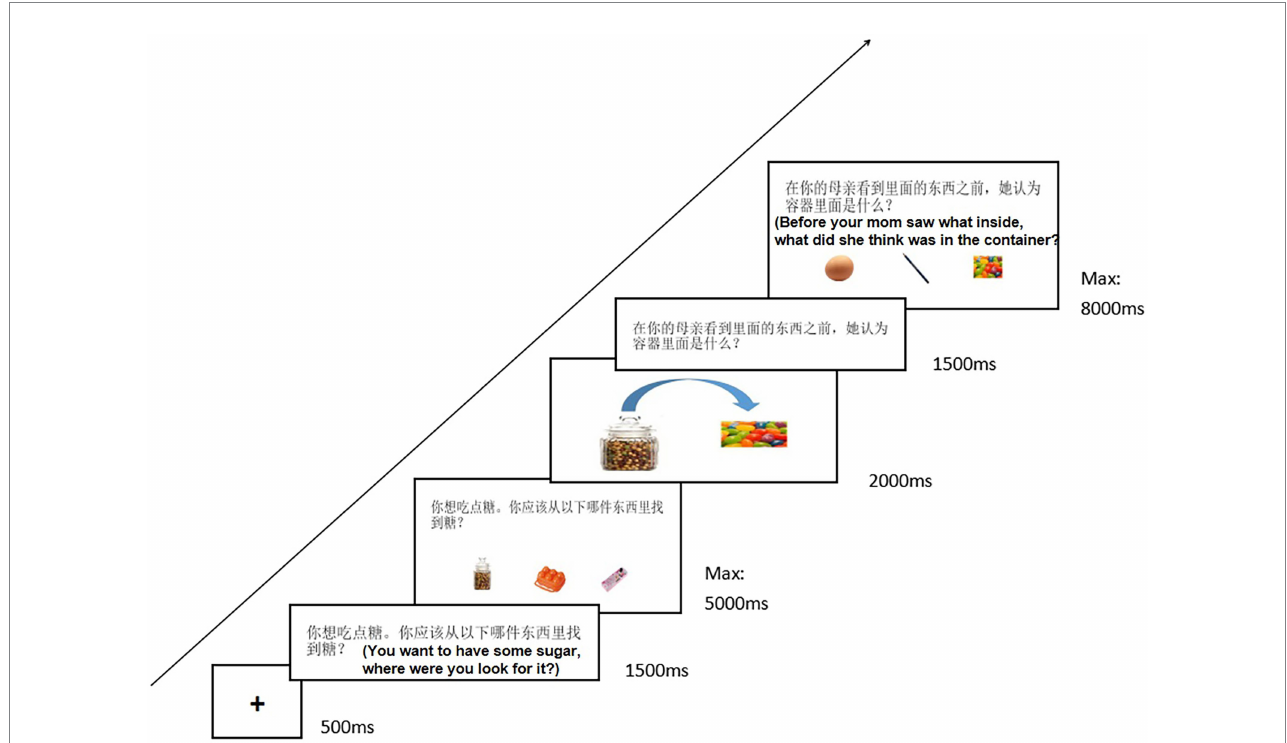
FIGURE 1 Illustration of the different stages of a single trial in the Self/Other Differentiation Task: the Dilemma Stage (‘Self’, ‘Close other’, or ‘stranger’), Consents Revelation Stage (Excepted or Unexpected), and Probe Stage (‘Self’, or